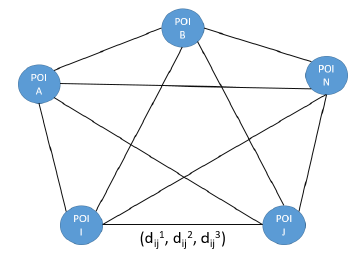
Figure 12. Travel time